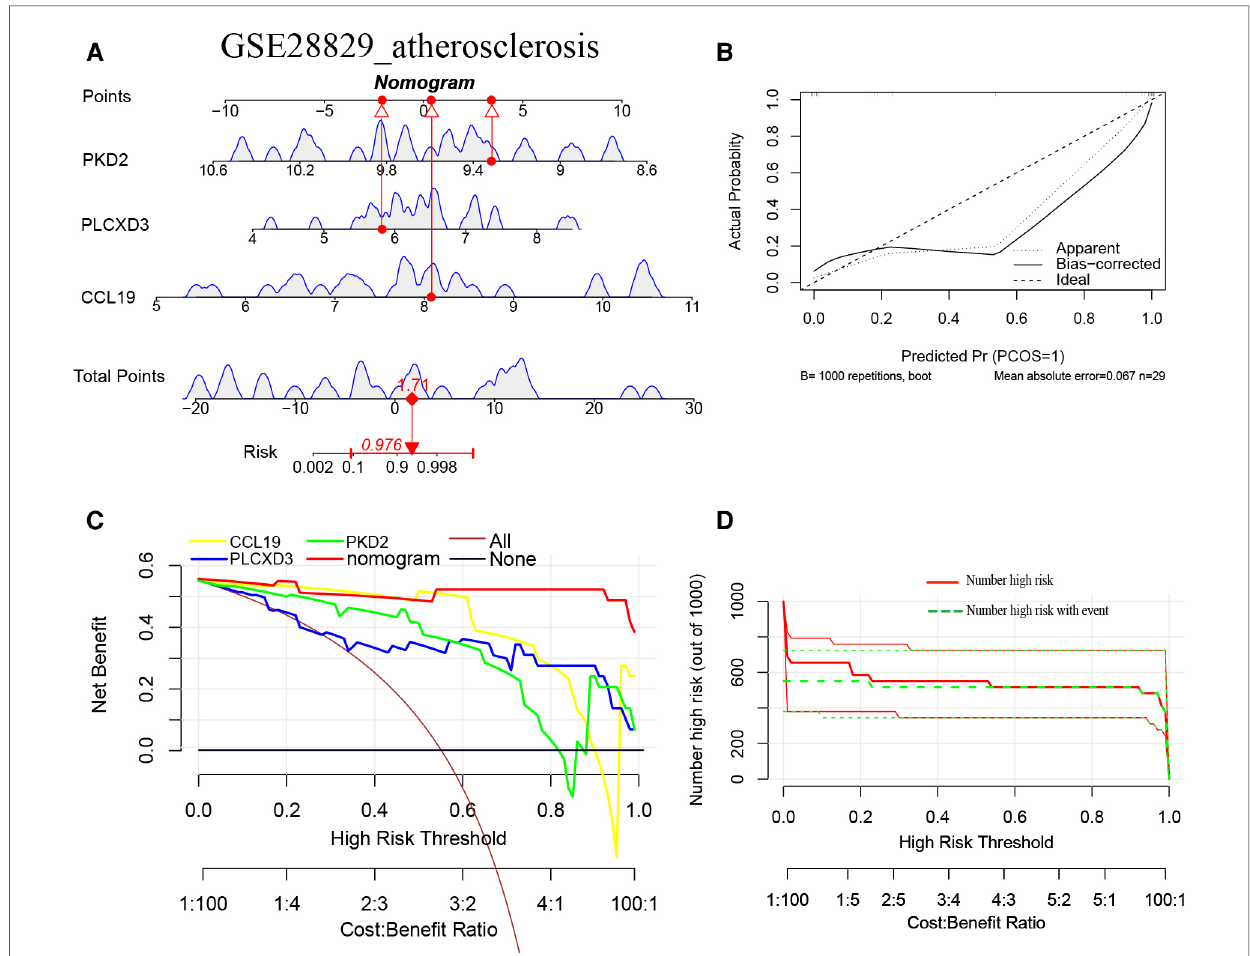
FIGURE 7 ( A ) The nomogram model predicting AS based on three common signature genes in GSE28829. The nomogram is used by summing all points identi fi ed on the scale for each variable. The total points projected on the bottom scales indicate the probabilities of AS; ( B ) the calibration curves for the nomogram with the mean absolute error=0.067; ( C ) DCA of the nomogram model and each common signature gene (the “ All ” means diagnosis-all strategy; the “ None ” means diagnosis-none strategy) and the nomogram model had a higher net bene fi t at all practical risk thresholds (from 0 to 1.0); ( D ) the CIC of the nomogram